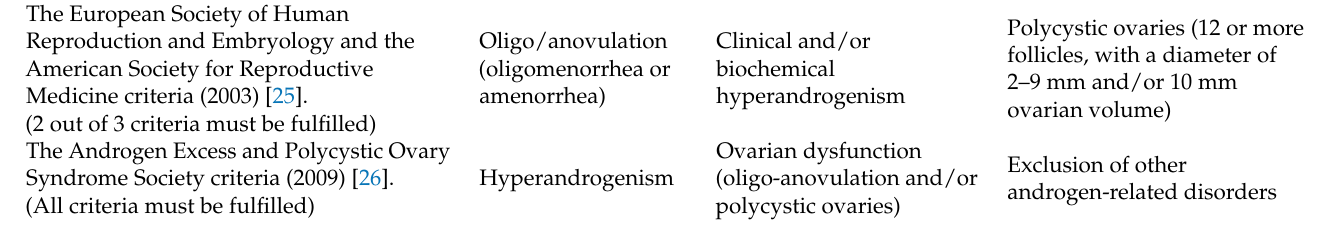
Table 1. Diagnostic criteria for polycystic ovary